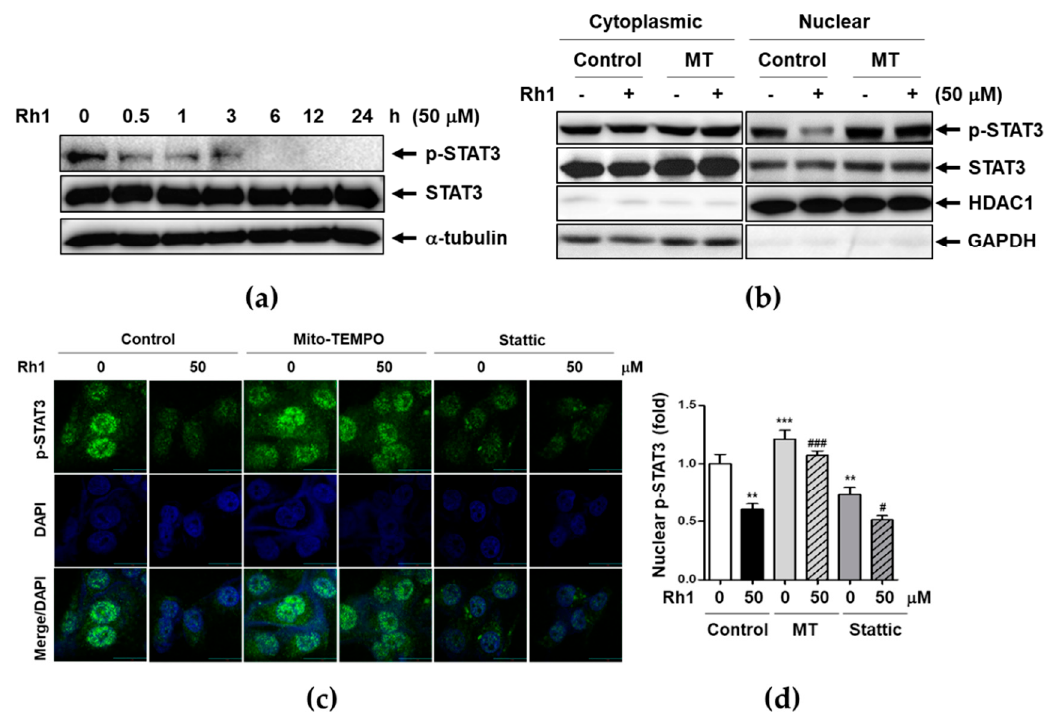
Figure 5. Rh1 inhibited STAT3 activation via inducing mtROS. ( a ) MDA-MB-231 cells were treated with 50 µ M Rh1 for indicated time intervals. ( b ) MDA-MB-231 cells were pretreated with 5 µ M MT for 1 h followed by treatment with 50 µ M Rh1 for 30 min. After fractionation, protein localization was evaluated by western blot analysis. ( c , d ) MDA-MB-231 cells were pre-treated with 5 µ M MT or 1 µ M stattic followed by treatment with 50 µ M Rh1 for 30 min. After treatment, cells were subjected to immunofluorescence staining, and p-STAT3 expression in cells was observed using a laser scanning confocal spectral microscope. The fluorescence intensity was measured using an Image J software and indicated as fold change compared to the control (0) sample. The scale bar indicates 30 μ m. The data are presented as means ± SEM ( n = 3). ** p < 0.01 or *** p < 0.001 vs. control. # p < 0.05 or ### p < 0.001 compared with each inhibitor alone.